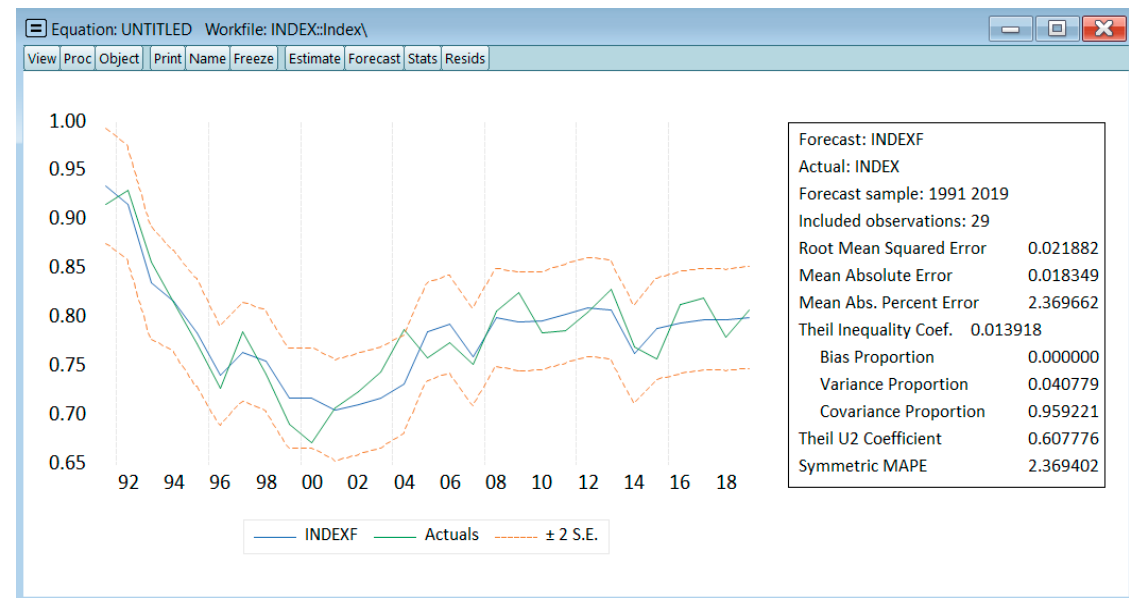
Figure A2. Forecasting according to the regression model for Ukraine.